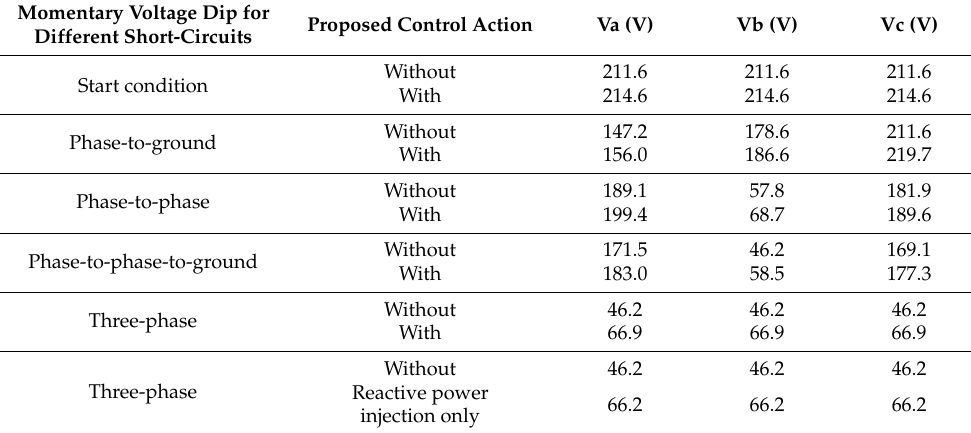
Table 6. Resume the voltage variations for each of